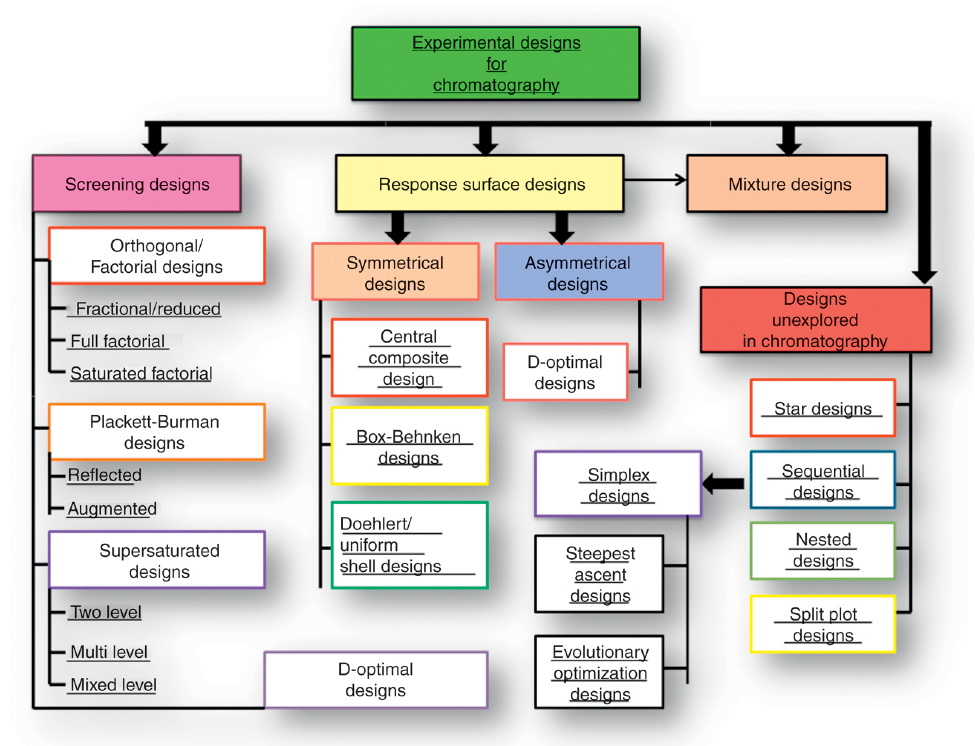
Figure 3: Arbitrary classification for various types of EDs used in the literature for chromatographic